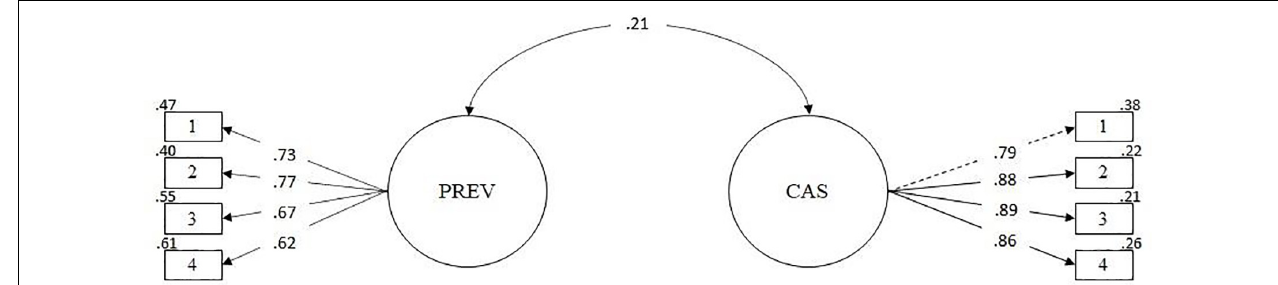
FIGURE 3 | Modelo de relación con otros